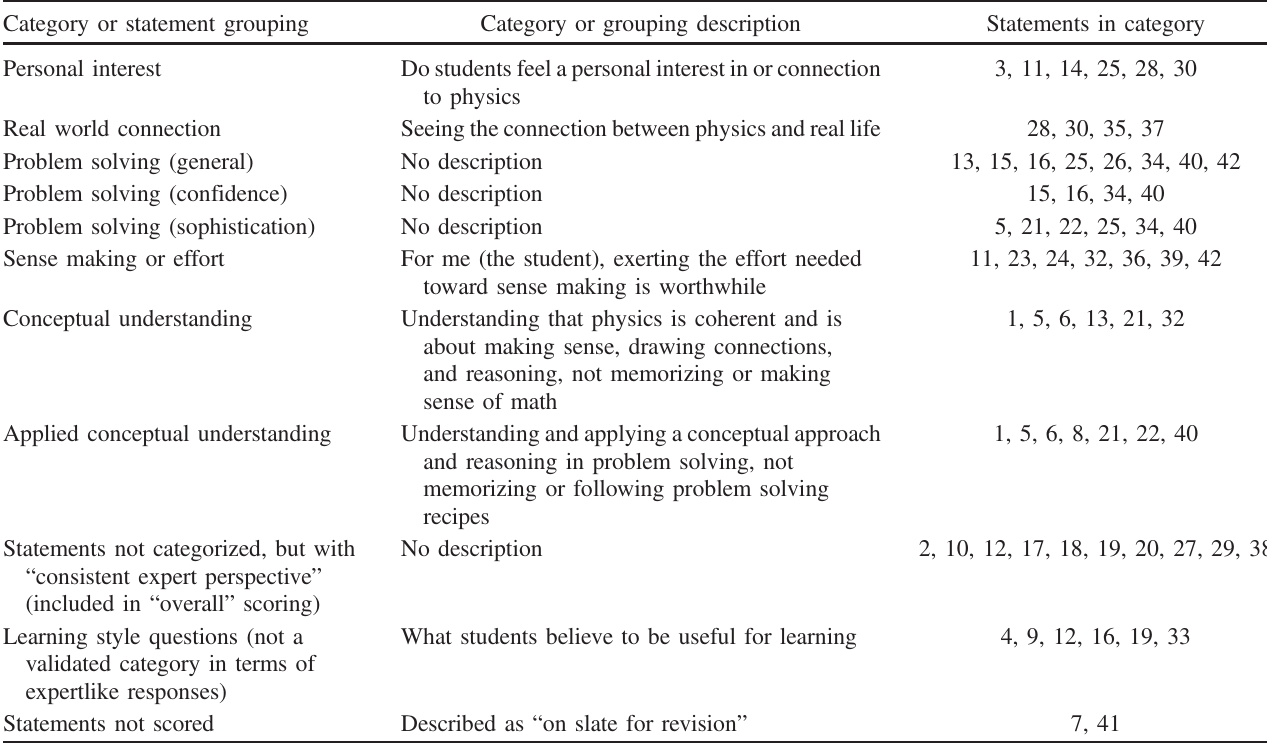
TABLE II. Categories and statement groupings in CLASS